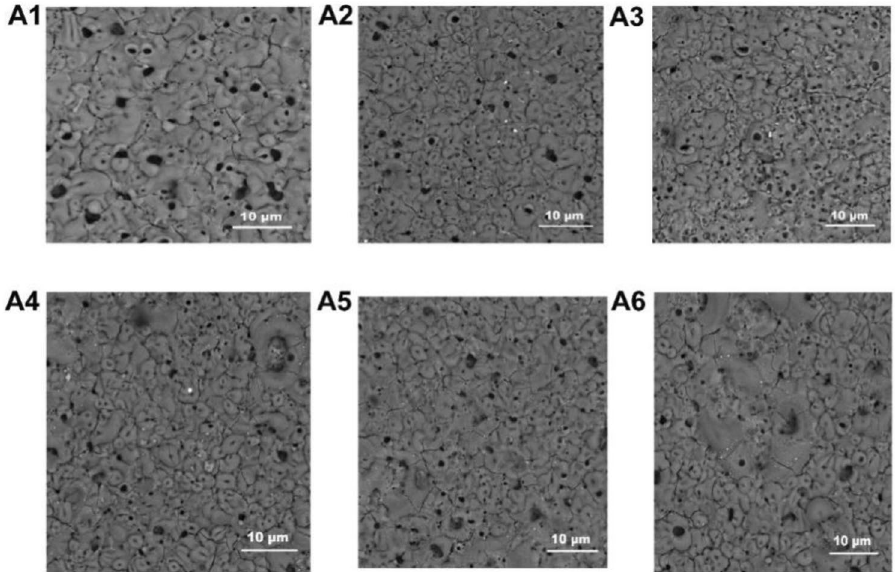
Figure 2. The surface morphologies of the MAO coatings ( A1 ): The concentration of NCNs is 0 g/L; ( A2 ): 0.4 g/L; ( A3 ): 0.8 g/L; ( A4 ): 1.2 g/L; ( A5 ): 1.6 g/L; ( A6 ): 2.0 g/L; Adobe Illustrator CS5, https:// www. adobe. com/ cn/ produ cts/ illus trator. html#